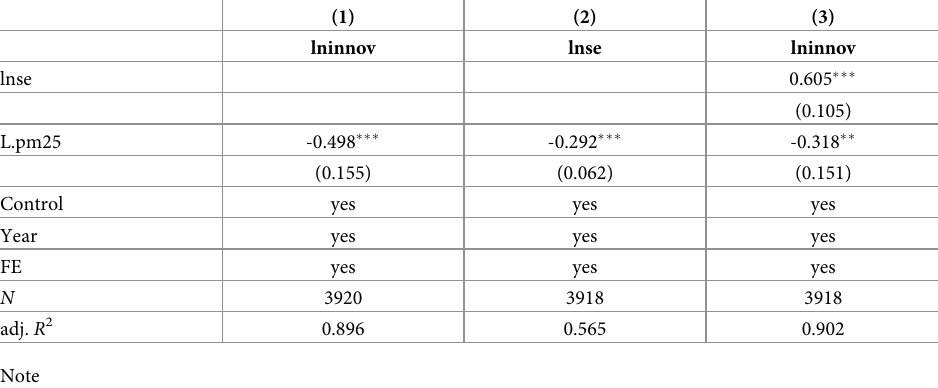
Note � , �� , ��� represent significant at 10%, 5% and 1% significant levels, respectively. FE represent city fixed effects. Year means year fixed effects. Regression uses heteroscedasticity robust standard errors. Values below coefficients are standard errors. Constant term coefficient is not reported.